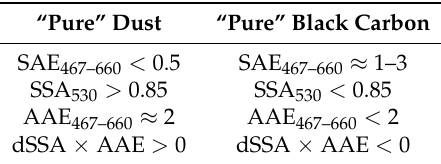
Table 3. Intensive optical properties (SAE, SSA, AAE, and dSSA × AAE) of “pure” dust and “pure” black carbon aerosol resulting from the "paradigm" developed in